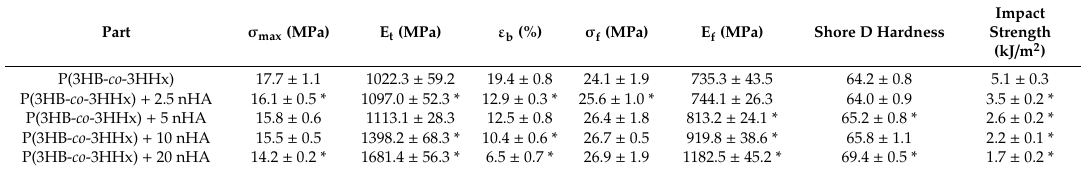
Table 3. Mechanical properties of the injection-molded parts of poly(3-hydroxybutyrate- co -3-hydroxyhexanoate) [P(3HB- co -3HHx)] / hydroxyapatite nanoparticles (nHA) in terms of maximum tensile stress ( σ max ), tensile modulus (E t ), elongation at break ( ε b ), maximum flexural stress ( σ f ), flexural modulus (E f ), Shore D hardness, and impact strength.